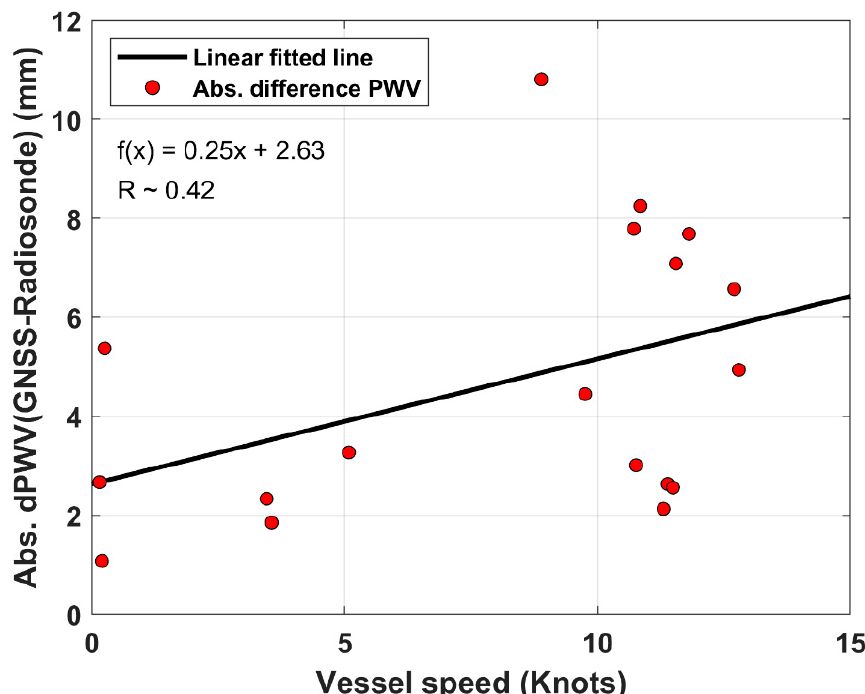
Figure 7. Correlation between absolute PWV difference (GNSS – Radiosonde) and vessel ISABU speed. The red dots denote the absolute difference between GNSS-PWV and radiosonde-PWV. The black solid line represents the relationship between the two variables by fitting a linear regression approach. The relation between the two variables tends to increase with the vessel’s speed increase.